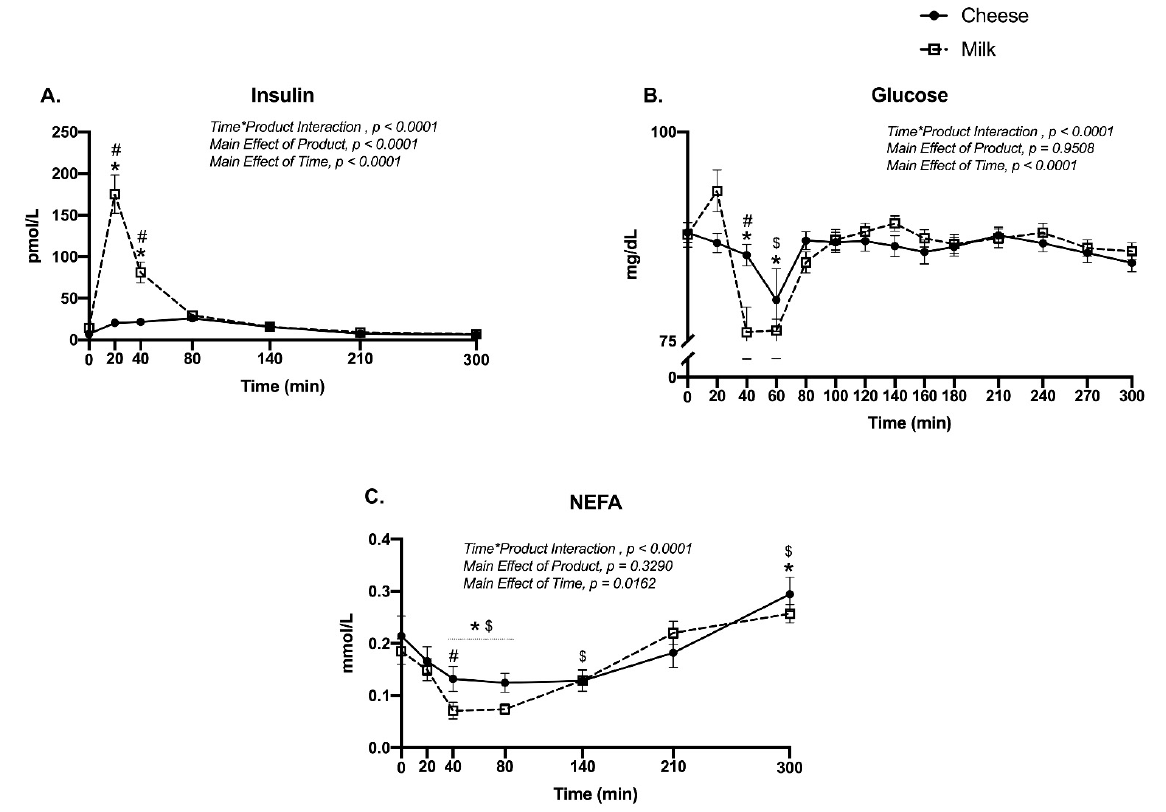
Figure 2. Plasma ( A ) insulin (pmol/L), ( B ) glucose (mg/dL), and ( C ) non-esterified fatty acids (mmol/L) in the fasted state (0 min) and over a 300 min time period following the ingestion of either cheese (solid line) or milk (dotted line) in men and women ( n = 24). Different from baseline (0 min) for milk (*) and cheese ( $ ), p < 0.05. # , Different between groups at the specific time point, p < 0.05.